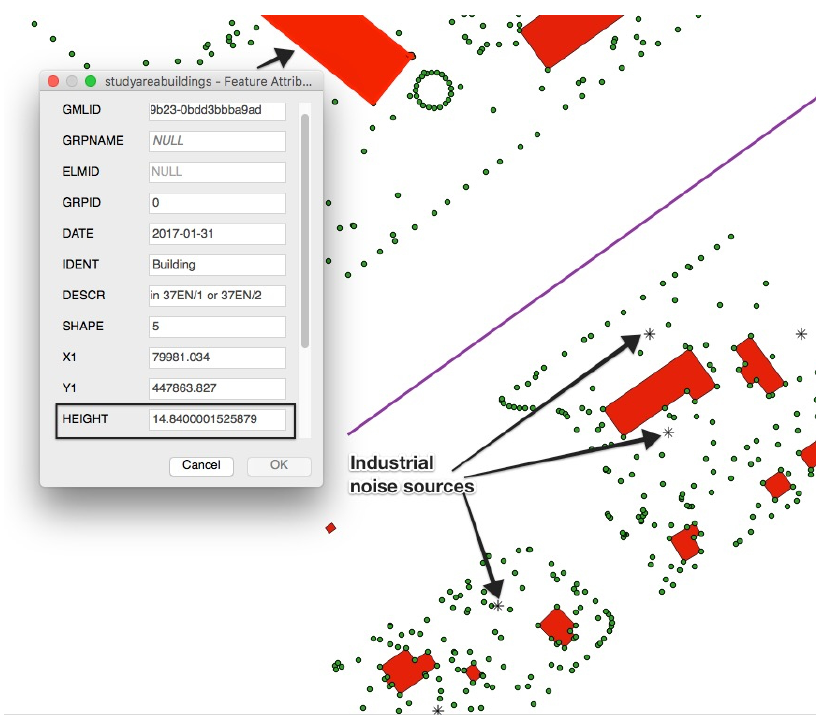
Figure 7: 2.5D input model for industrial noise with fictitious noise sources.(Height of the feature is stored as attribute to reconstruct the 3D geometry in output